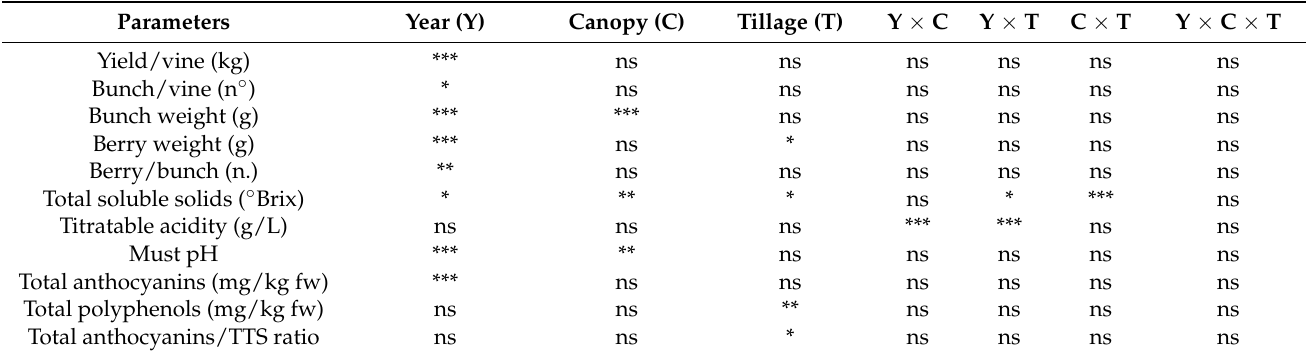
Table 4. Tukey’s post-hoc test ANOVA on yield characteristics and main berry quality attributes. Interactions are indicated by: * Significant p < 0.05; ** Significant p < 0.01; *** Significant p <